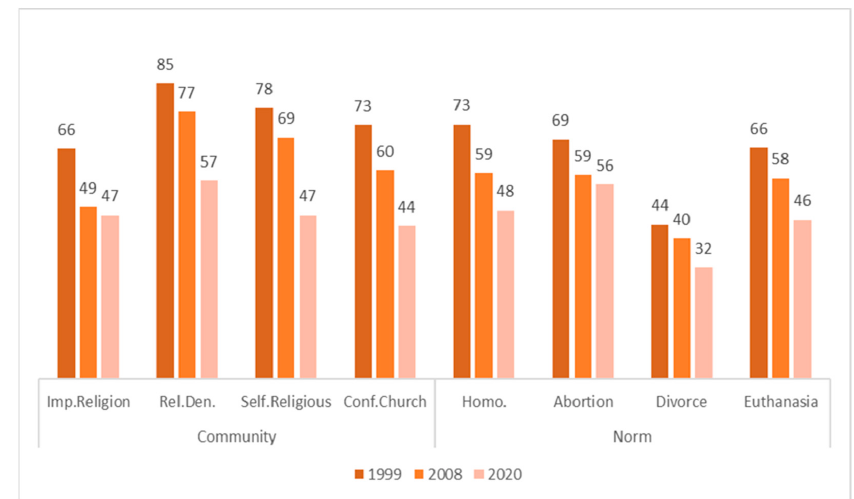
Figure 4. Community and norm variables by round in Portugal in 2020 (%). Source: EVS (2021). Notes: Significant differences exist between all rounds with the following exceptions: in Importance